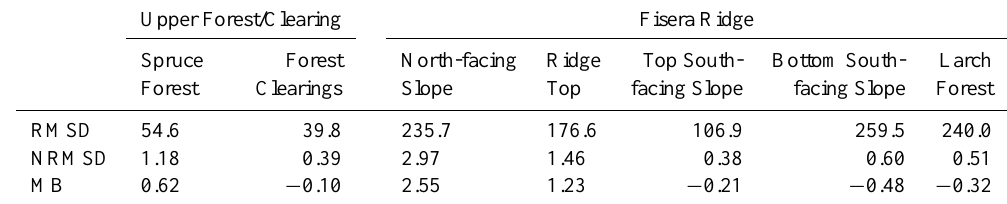
Table 6. Root mean square difference (RMSD, mmSWE), normalised RMSD (NRMSD), and model bias (MB) for the falsifying model simulations at Upper Forest/Clearing and Fisera Ridge sites, Marmot Creek Research Basin during seasons from 2007 to 2011. Upper Forest/Clearing Fisera Ridge Spruce Forest Bottom South-